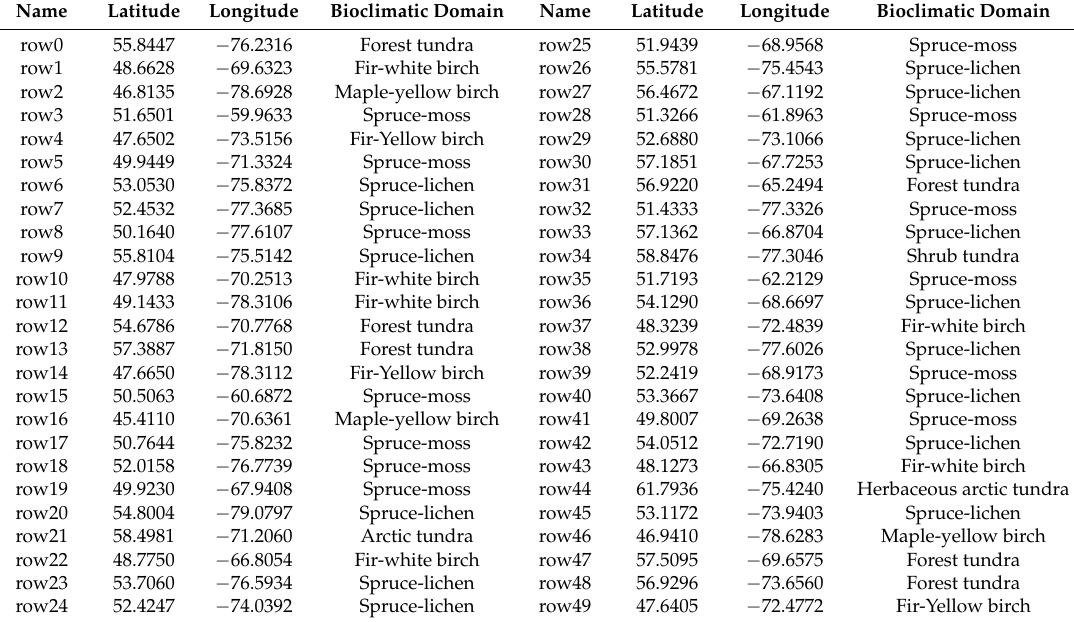
Table 3. Complementary information regarding the geographical coordinates as well as the specific bioclimatic domains where each of the sample sites are located.